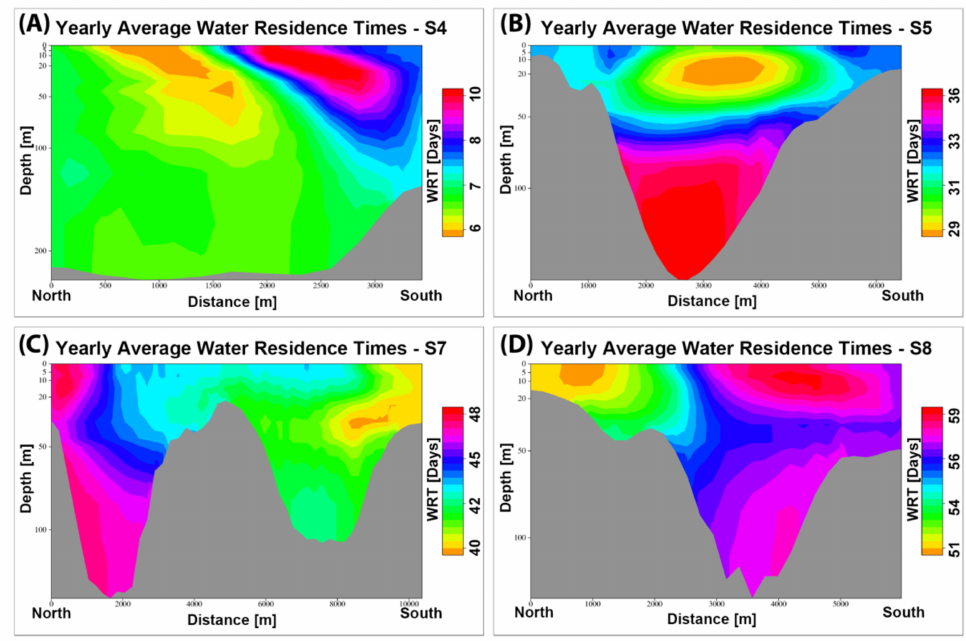
Figure 10. Vertical distribution of the yearly average water residence times along the main sections of the BC (see Figure 2D).